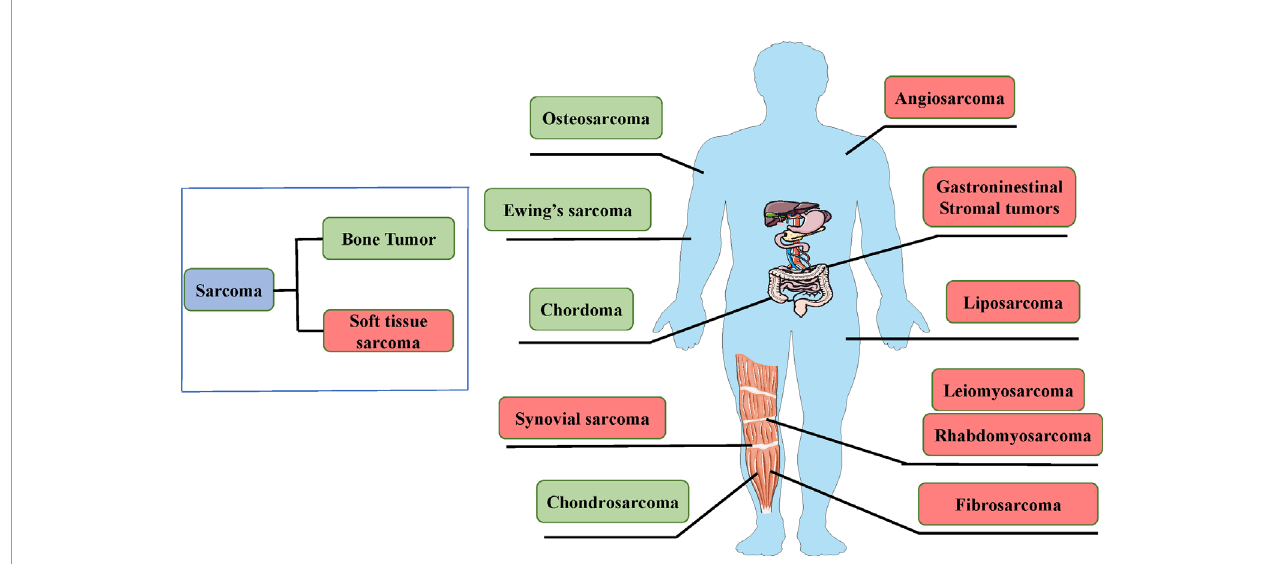
FIGURE 1 | The main sarcoma types are bone tumors and soft tissue